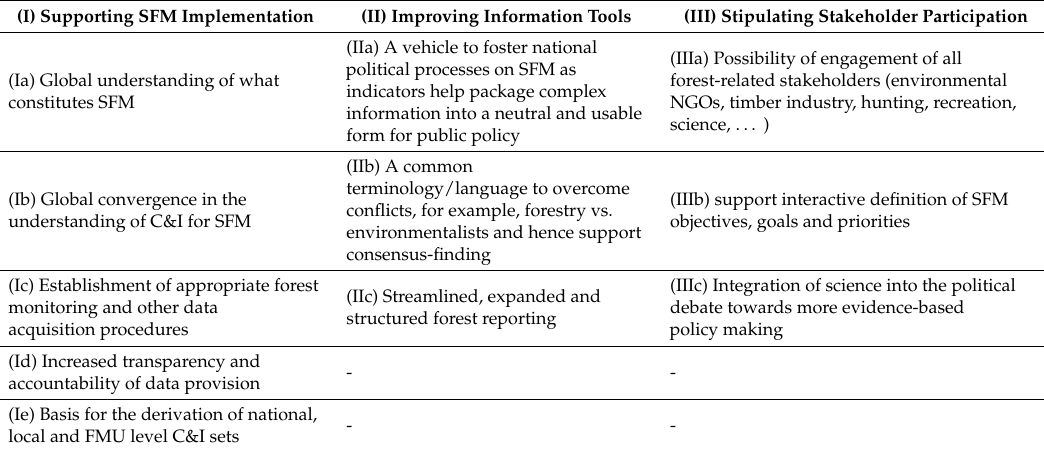
Table 3. Common achievements of regional and international C&I